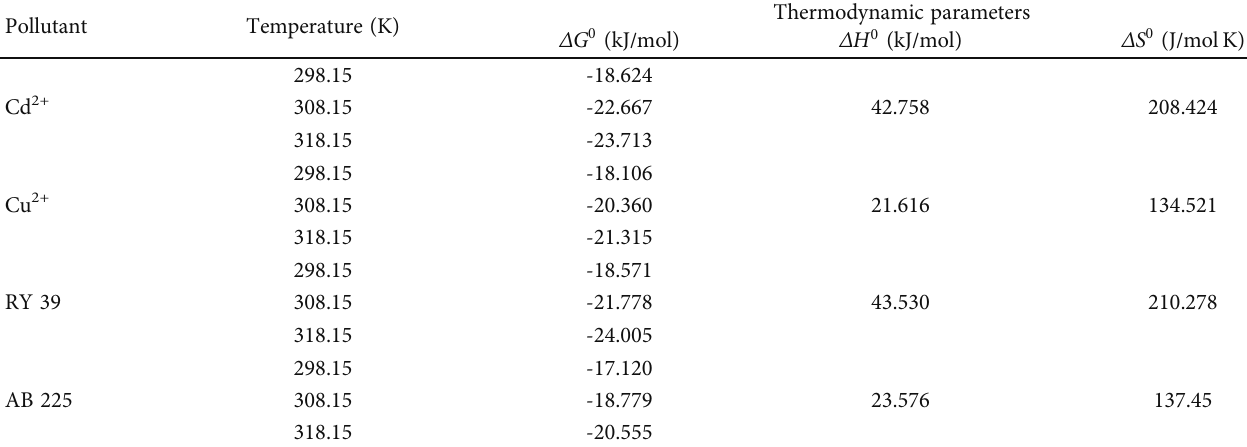
Table 6: Thermodynamic parameters for adsorption of di ff erent pollutants onto SH-PO1.